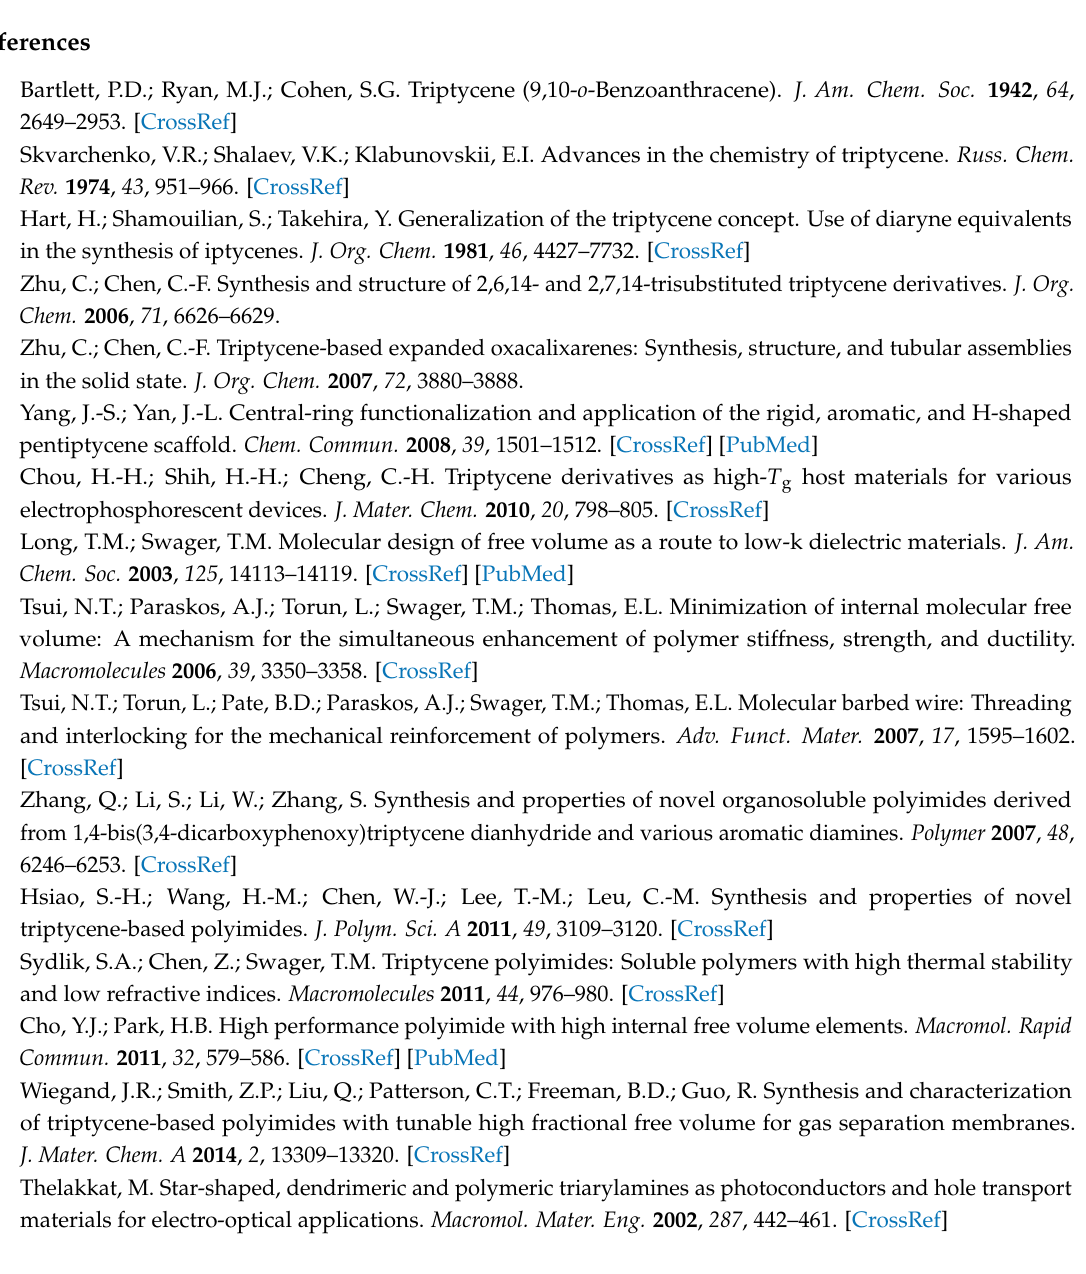
Figure S1: IR spectra of model compounds M1 and M2, together with compounds 4 , 7 and 8 ; Figure S2: (a) 1 H NMR and (b) H-H COSY spectra of M1 in DMSO- d 6; Figure S3: (a) 1 H NMR and (b) H-H COSY spectra of M2 in CDCl 3 ; Figure S4 − S6: Mass spectra of the synthesized compounds; Figure S7: Potential step absorptiometry of the cast film of NPC-TPPI on the ITO-glass slide (coated area ~1 cm 2 ) (in CH 2 Cl 2 with 0.1 M Bu 4 NClO 4 as the supporting electrolyte) by applying a potential